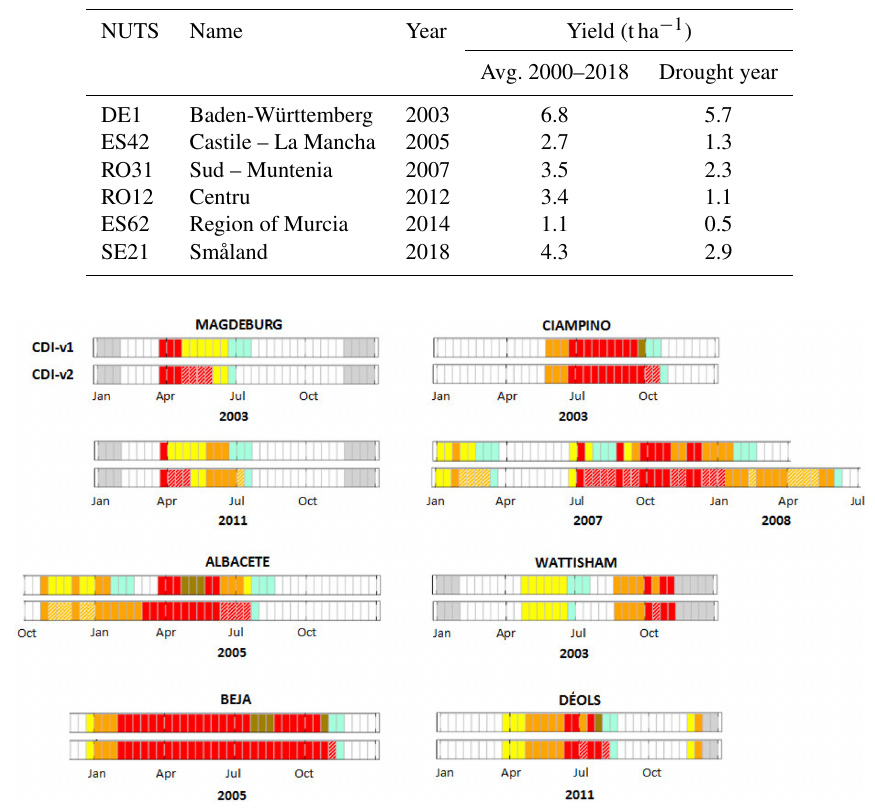
Figure 5. Time series of CDI-v1 (upper lines) and CDI-v2 (lower lines) for different test sites under drought between 2001 and 2011, as documented in Sepulcre-Canto et al. (2012). See Figs. 1 and 4 for the corresponding legends. The labels on the x axis correspond to the beginning of the